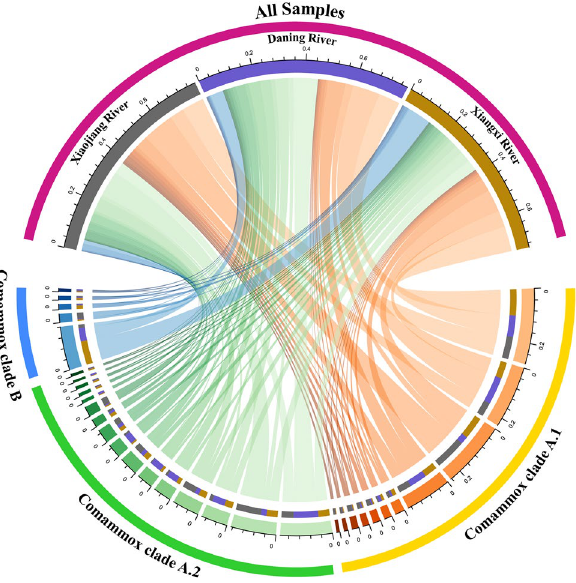
Figure 7. Distribution of 32 main OTUs among different sampling tributaries.